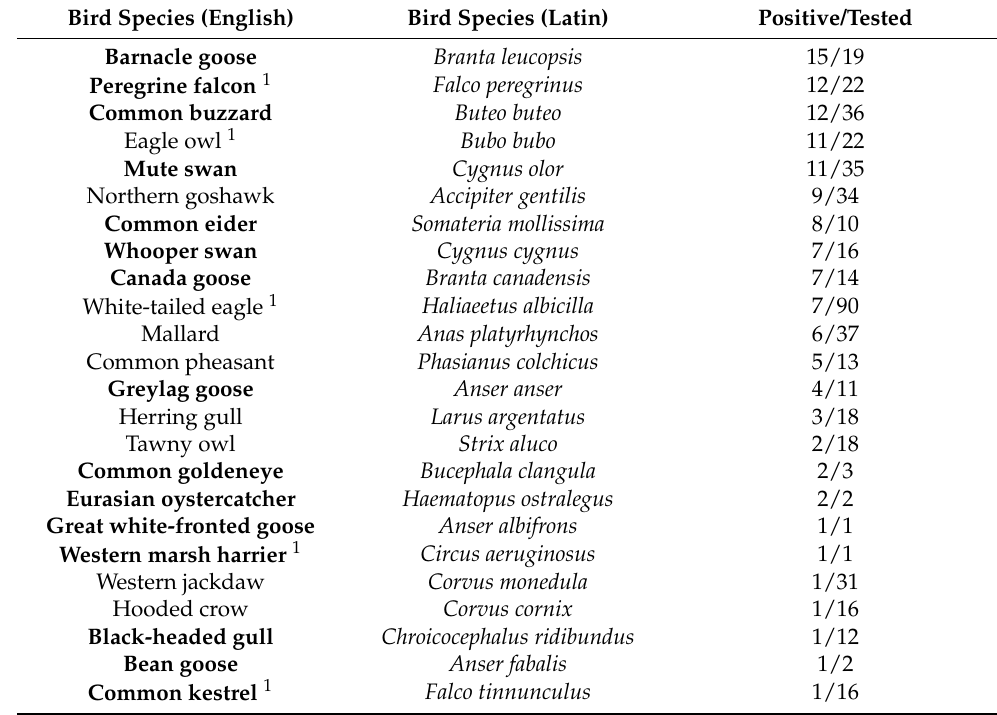
Table 1. Wild bird species infected with HPAI H5Nx (clade 2.3.4.4) in Sweden during the 2020–2021 season. The numbers represent infected birds (positive) and the total number of tested birds of each species. In nine birds, pathogenicity was inconclusive but was assumed to be high. Migratory birds are indicated with bold